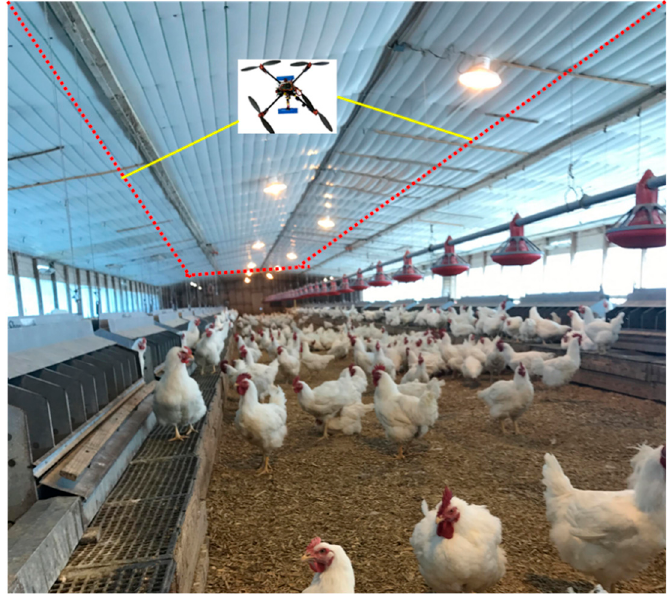
Figure 5. The poultry house model used for simulating UAV landing and control (the house was measured 135 L × 15 W × 3 H m; the photo was taken by authors in a commercial broiler breeder house in Georgia, USA).